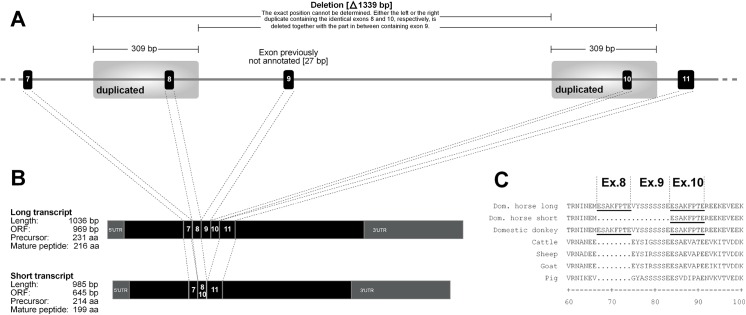
Structure of the long and short equine αs2-casein variants.A. Genomic organization of the respective gene segment. Grey shading indicates the equid specific 309 bp duplication comprising coding exons 8 and 10, respectively. The 1.3 kb in-frame-deletion is indicated above the figure. B. Structures the resulting transcript variants. C. Protein alignment of available ungulate αs2-casein protein sequences.